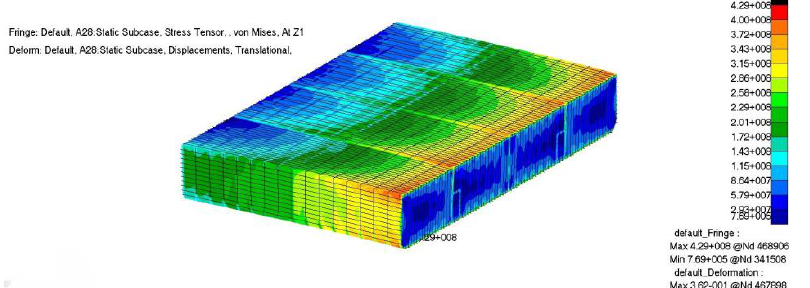
Figure 25. Stress cloud map of decks 4 and 5 at the high tide level of the ship on the day of the incident.